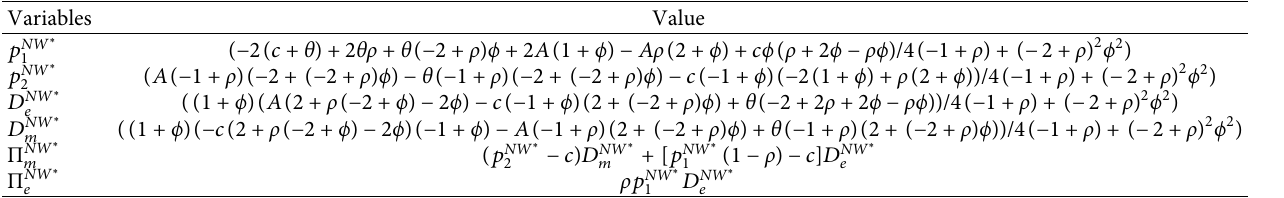
Table 3: Demand, profit, and optimal decisions in the direct and delegation sales models.